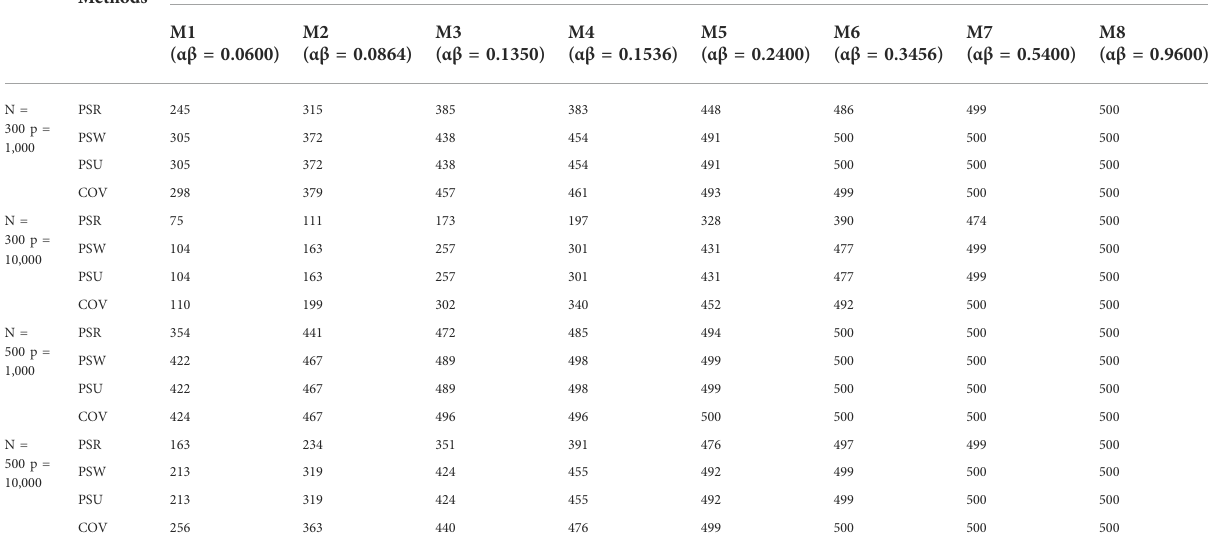
TABLE 1 Correct selection numbers for the eight true mediators (M1 – M8) ( α (cid:1) 0 . 6 t , β (cid:1) 0 . 4 t ) MCP correct selection numbers Methods